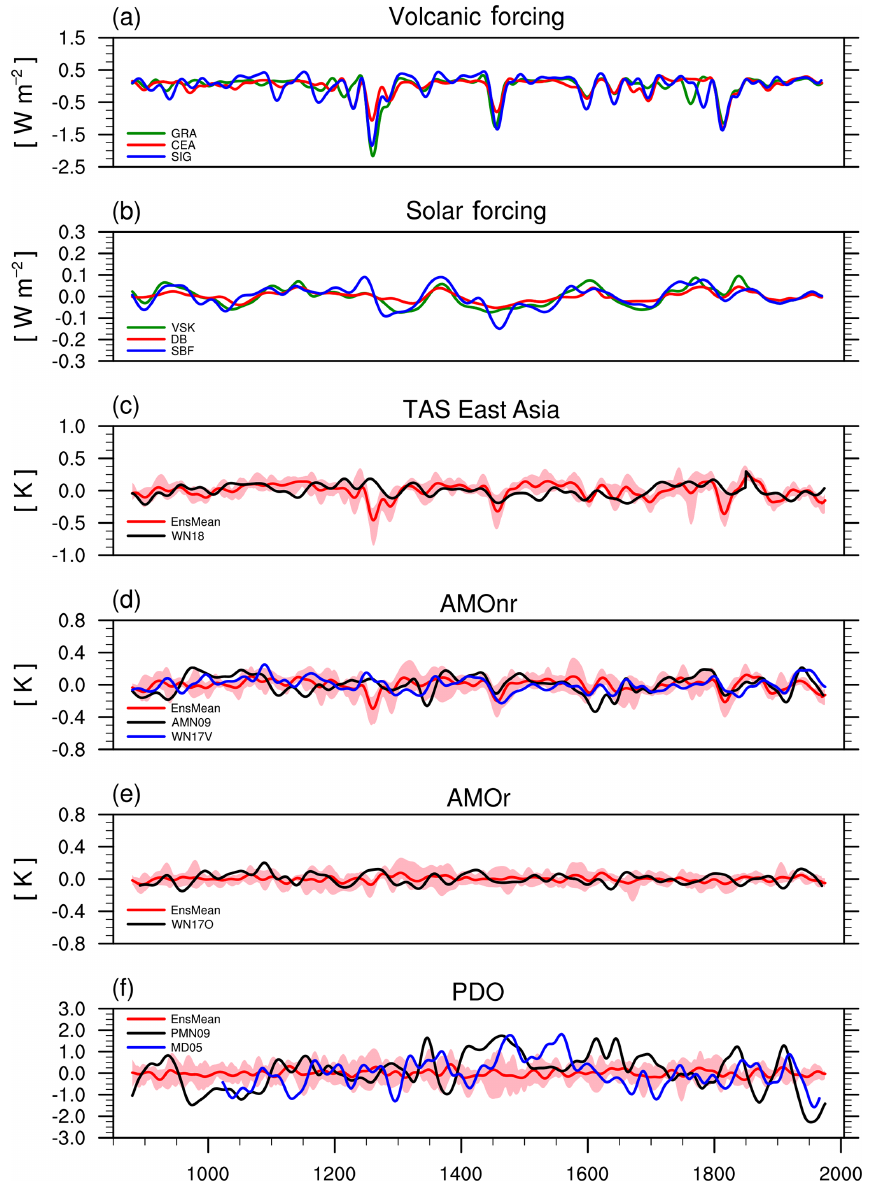
Figure 7. Time series of (a) volcanic forcing, (b) solar forcing, (c) surface temperature over East Asia, (d) AMO index without subtracting the global SST (AMOnr), (e) AMO index after subtracting the global SST (AMOr) and (f) PDO index; all are annual-mean values, passed through a 30-year low-pass filter and truncated to remove filter end effects. Model simulations in panels (c) – (f) are given as the mean (red line) and spread (pink shading) of the seven GCMs. Model simulations for surface temperature, AMO and PDO are compared with the available reconstructed data (black and blue